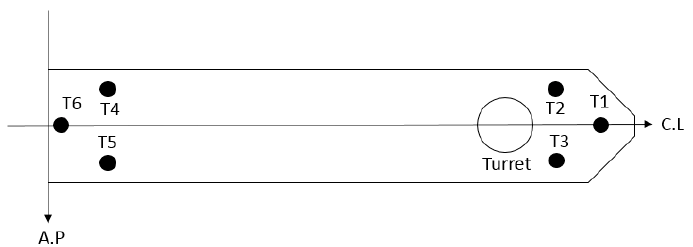
Figure 13. Thruster Configuration. Table 7. Thruster Information.